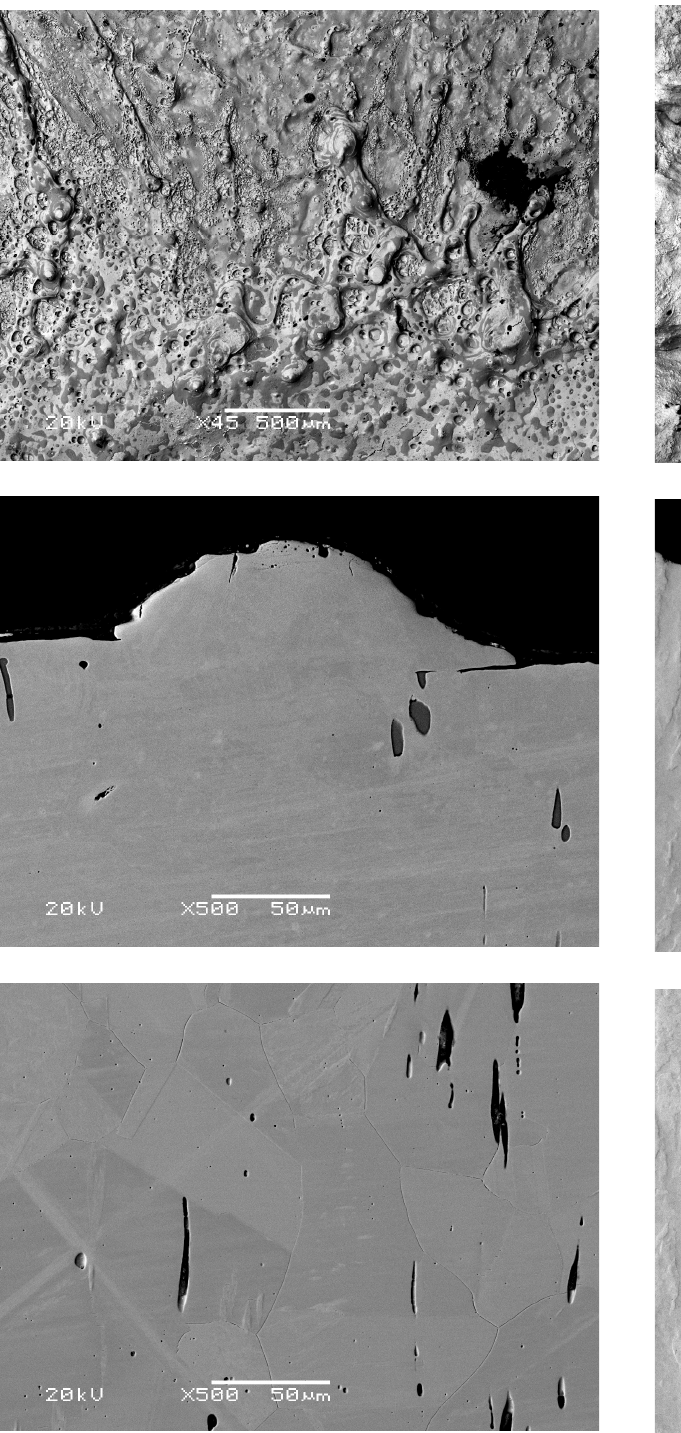
FIG. 4. Backscattered electron micrograph for molybdenum. The top picture is a surface picture of an arc region. The middle picture is a cross section of an arced region. The bottom picture is a cross section of the bulk